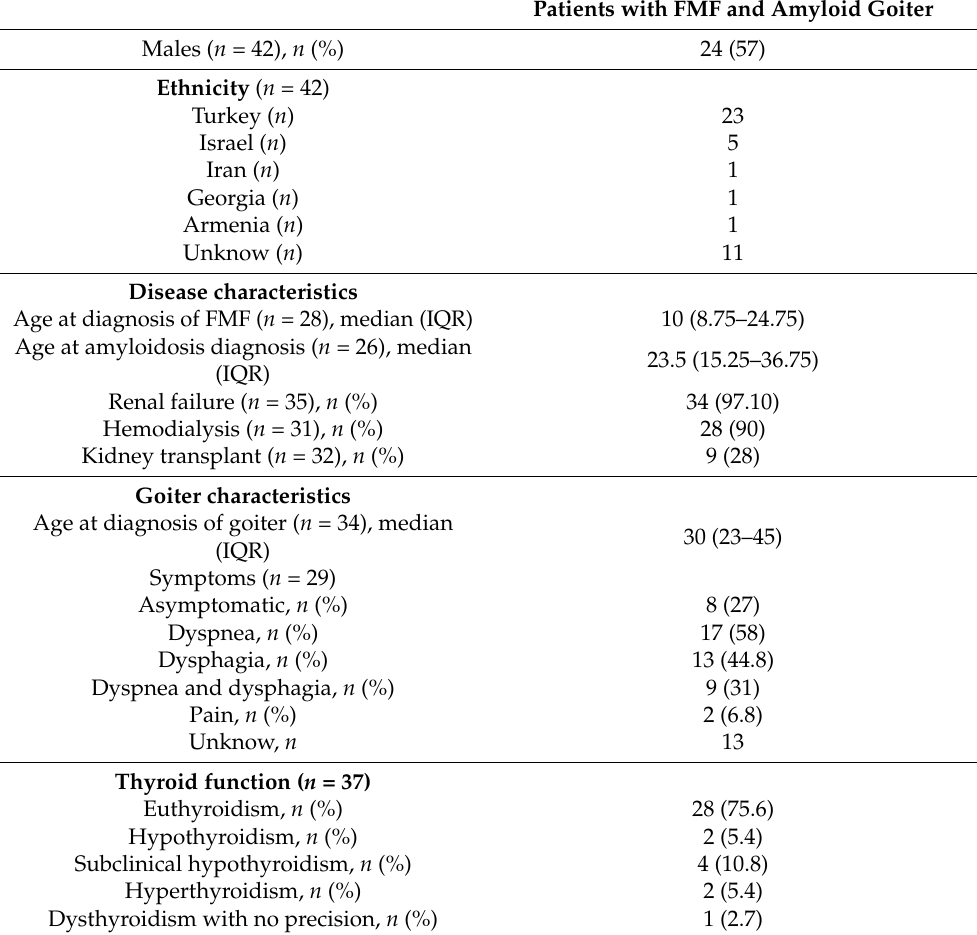
Table 1. Main features of the